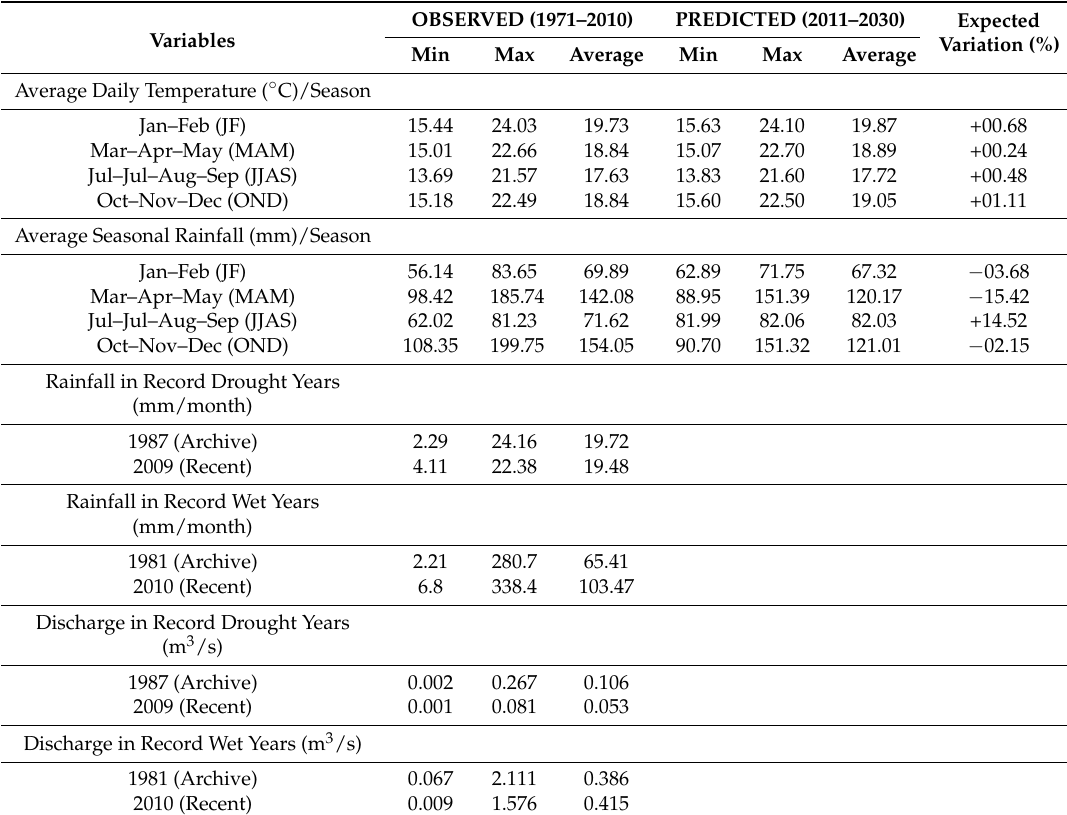
Table 2. Hydro-climatic variables benchmarked in Muooni catchment (1971–2030).